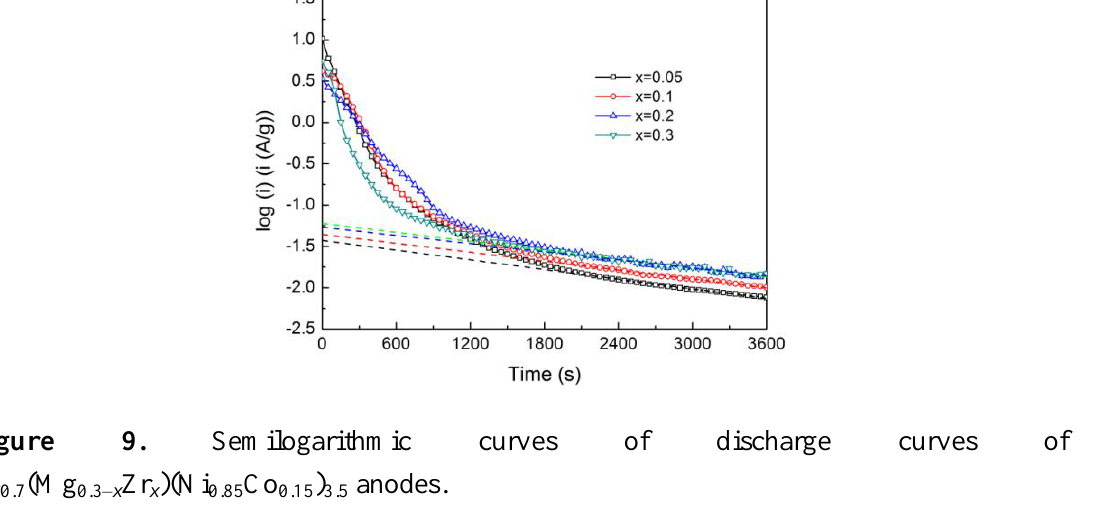
(Mg Zr )(Ni Co ) anodes. 0.7 0.3– x x 0.85 0.15 3.5